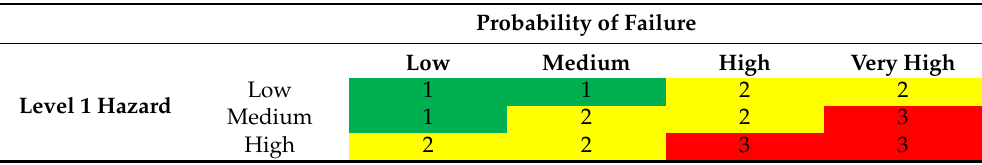
Table 2. Matrix and criteria used for the identification of the Level 2 rockfall hazard (1—Low, 2—Medium,